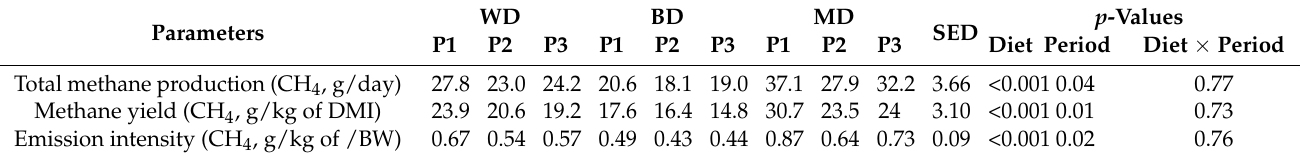
Table 2. Effects of different experimental periods and diets on the methane variables 1